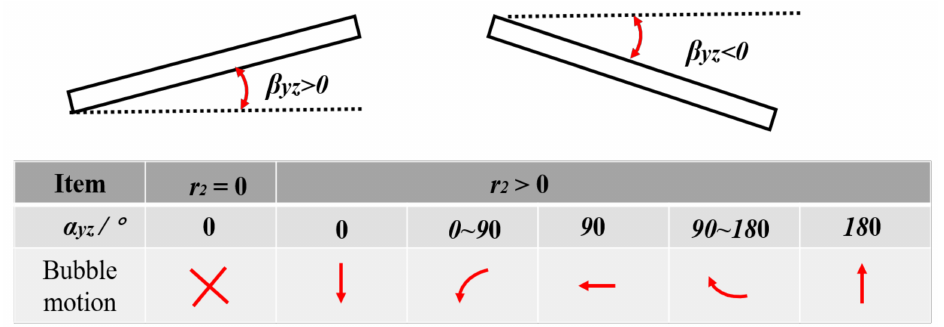
Figure 10. Physical meanings of bending angle ( β yz ) of composites and bubble migration trajectory (r 2 , α yz